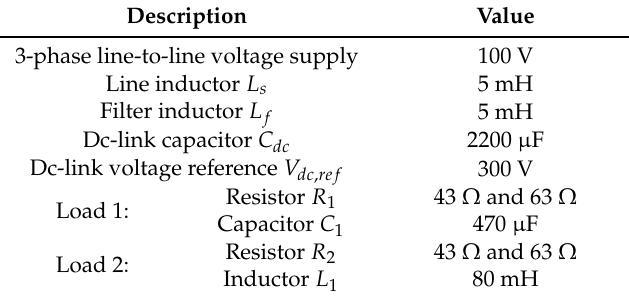
Table 2. Specification adopted in both simulation and experimental work.